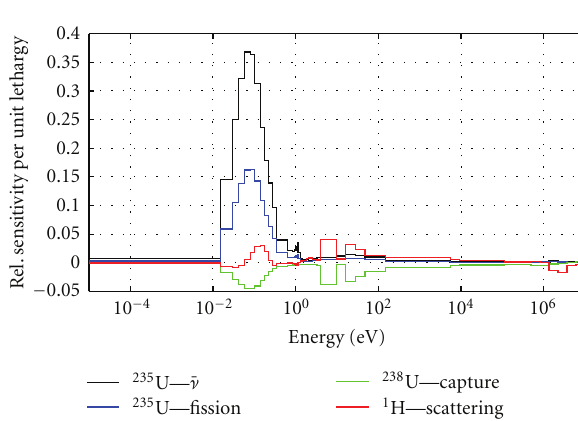
Figure 3: Self-shielded multigroup cross-sections corresponding to the test problem.